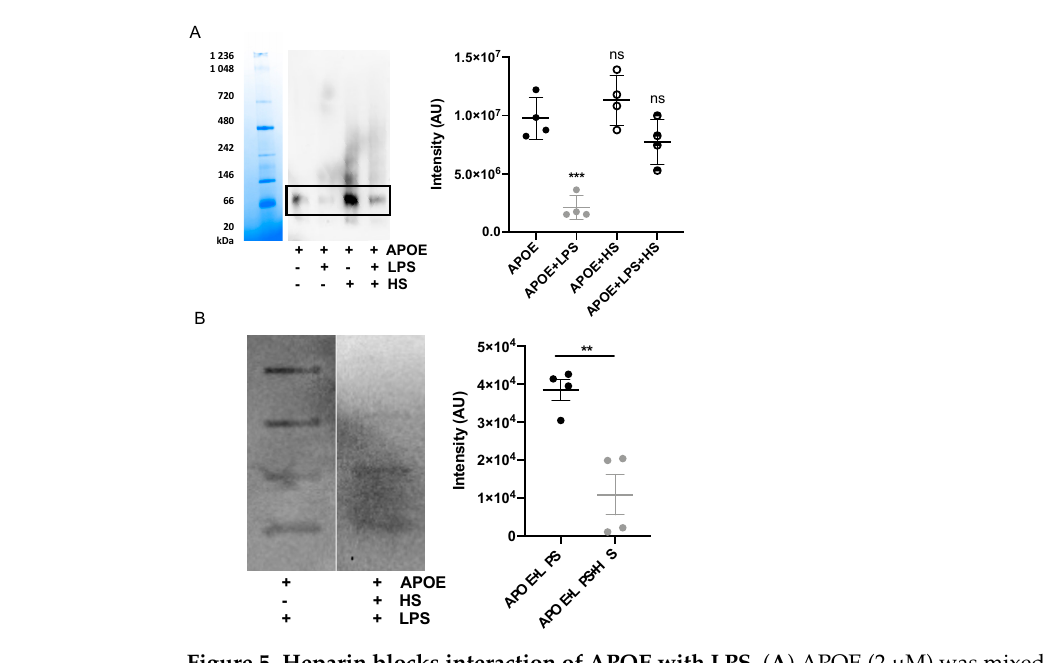
Figure 5. Heparin blocks interaction of APOE with LPS. ( A ) APOE (2 µ M) was mixed with 10 mM Tris, 100 µ g/mL LPS with or without heparin. Samples were incubated for 30 min at 37 ◦ C and then run on Blue Native gel, which was followed by Western blot. One representative image from four independent experiments is shown (n = 4). The intensity of the bands representing dimer of APOE was measured. Statistical analysis was performed using a one-way ANOVA with Dunnett’s multiple comparison tests, *** = p ≤ 0.001 and ns = not significant. ( B ) A slot-blot assay demonstrated blocked binding of APOE (1 μ g) to biotin-labeled LPS after the addition of heparin. Statistical analysis was performed using a t -test, ** = p ≤ 0.01.